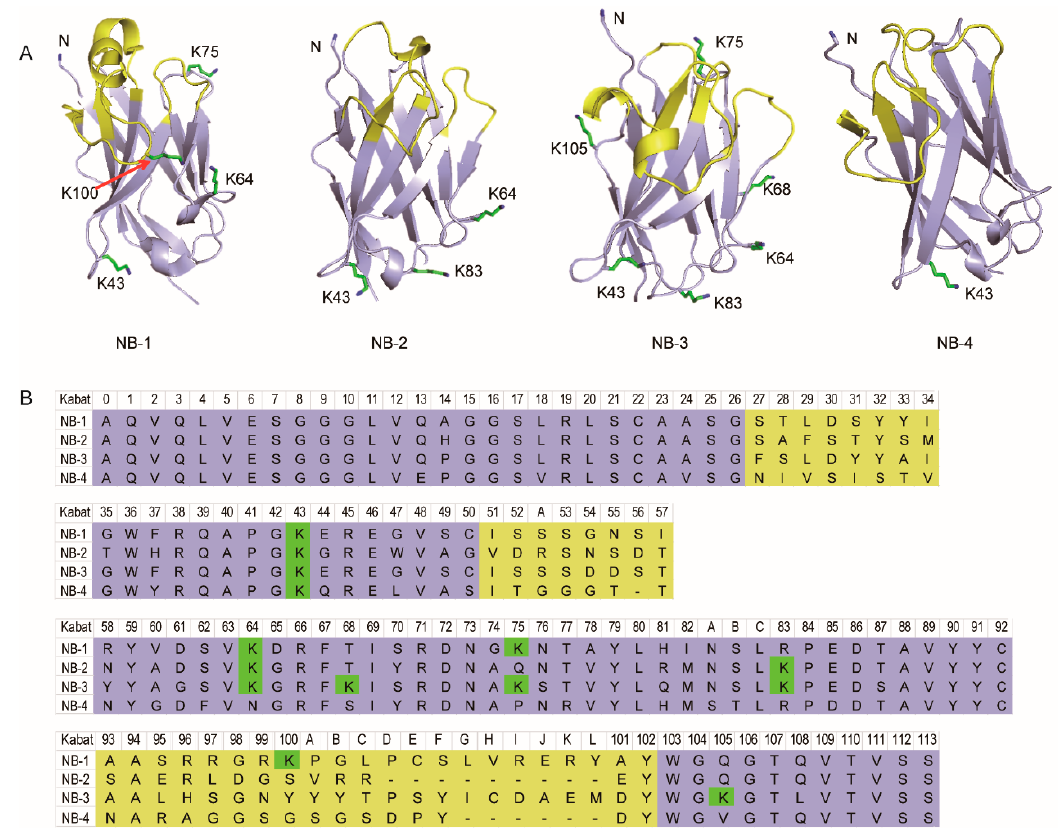
Figure 1. Stereoscopic structure, amino group distribution schematic ( A ) and sequences ( B ) of the selected four VHHs. The amino acid was numbered in Kabat scheme (n) instead of the real sequence number. “K” present lysine residue, “Kn” present the lysine residues located in Kabat scheme Hn, and “N” presents the N-terminal amino group.